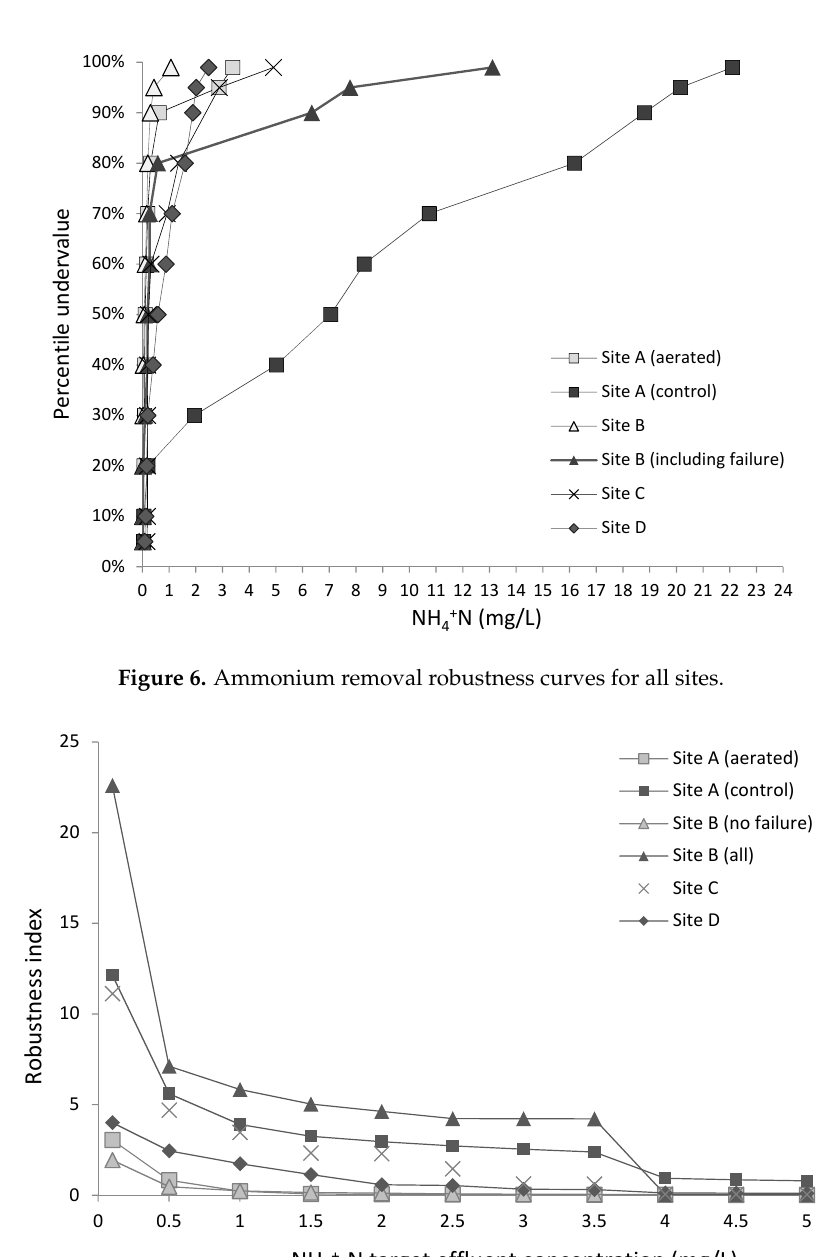
Figure 7. Robustness index ( RI ) of all sites against a range of target effluent concentrations.